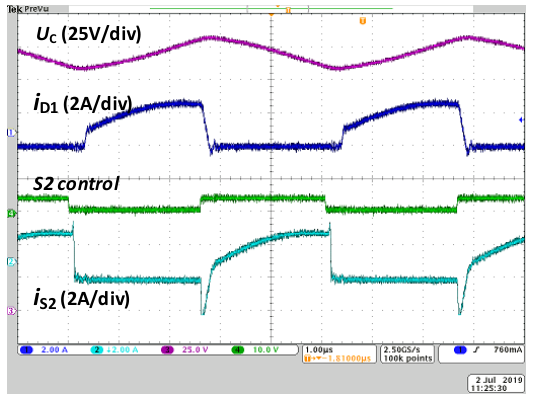
Figure 11. Steady-state operation of SCVD in Continuous Conduction Mode (CCM) and ZVS mode. Waveforms of voltage on switched capacitor C , current of D 1 , control signal of S 2, and current of transistor S 2. U in = 200 V, f S = 201.6 kHz, P out = 400 W, t M = 50 ns. Switching pattern P2.